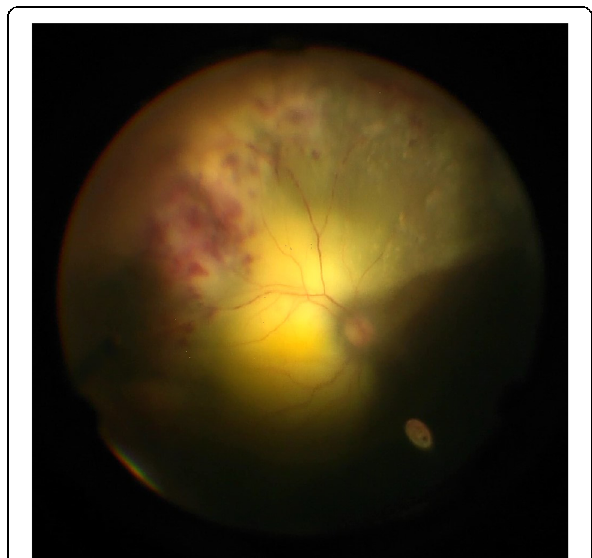
Fig. 3 Intraoperative photo of diagnostic pars plana vitrectomy of the left eye. Intraoperatively, a large exudative retinal detachment with significant subretinal yellow-white deposits, sclerotic vessels, and intraretinal hemorrhages was noted. No retinal breaks were